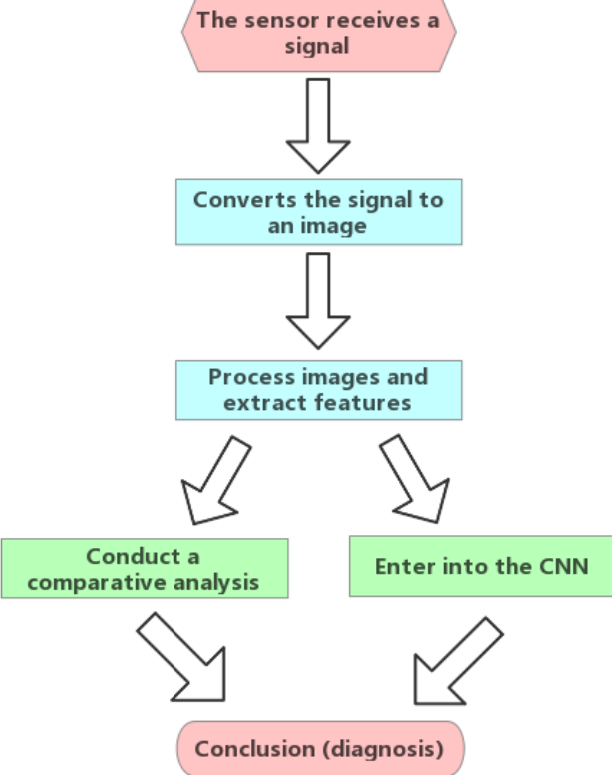
Figure 6. Flow chart of two-dimensional signal method summary.